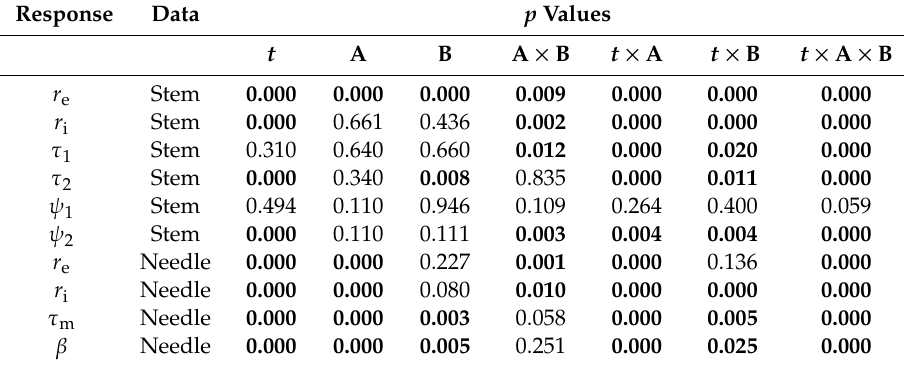
Table 1. The statistical significance of the e ff ects of A, B, sampling time, and their interactions on electrical impedance spectroscopy (EIS) parameters during the post-planting growth period, where A is the e ff ect of post-planting drought treatments, B is the e ff ect of pre-planting drought treatments, and t is sampling time e ff ect. p values ≤ 0.05 are in boldface. r e : specific extracellular resistance; r i : specific intracellular resistance; τ 1 and τ 2 : relaxation times; ψ 1 and ψ 2 : two distribution coe ffi cients